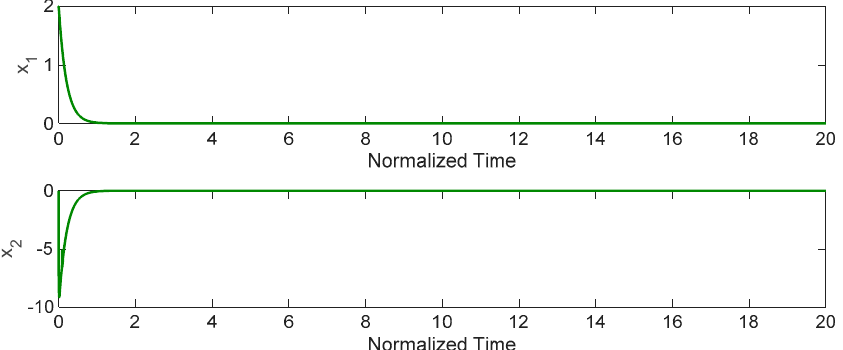
x 2 Figure 4. The states of the system based on the proposed control Figure 4. The states of the system based on the proposed control scheme.